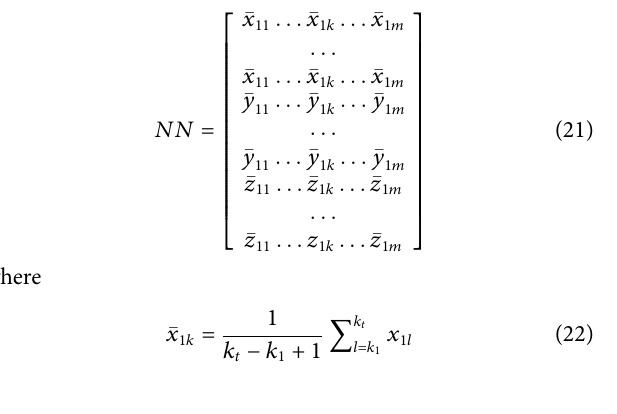
Frontiers in Energy Research |